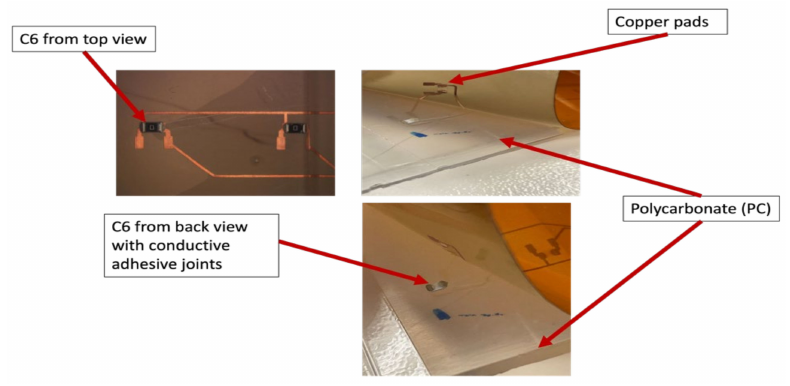
Figure 26. Poor adhesion between PI-Cu and